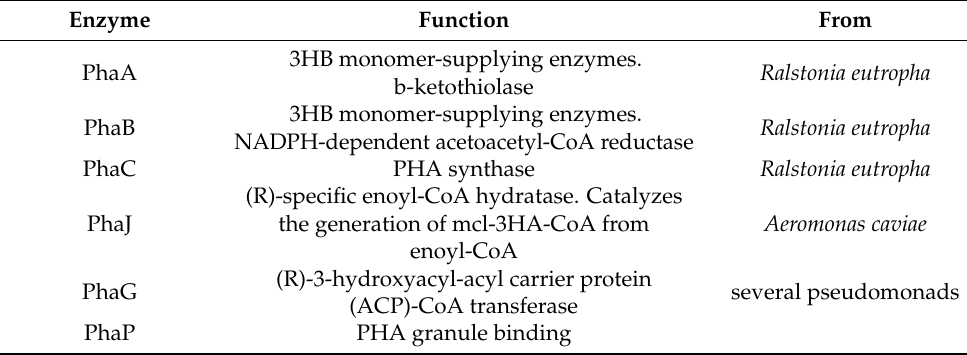
Ralstonia eutropha Ralstonia eutropha Aeromonas caviae several pseudomonads